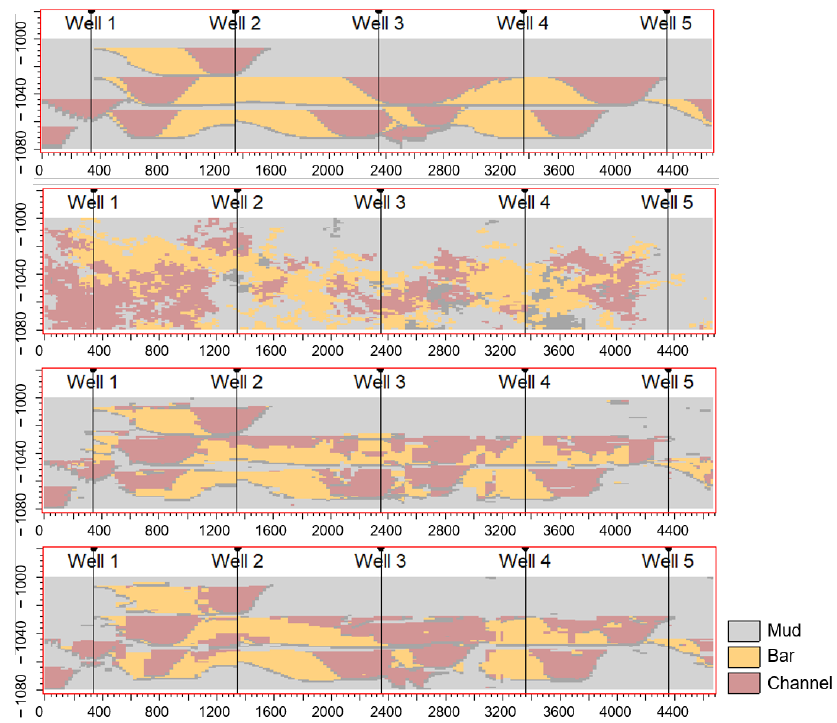
Figure 5. Lithofacies profiles of the five validation wells (from top to bottom , real reservoir, TPI, MPI, and LPUMI).